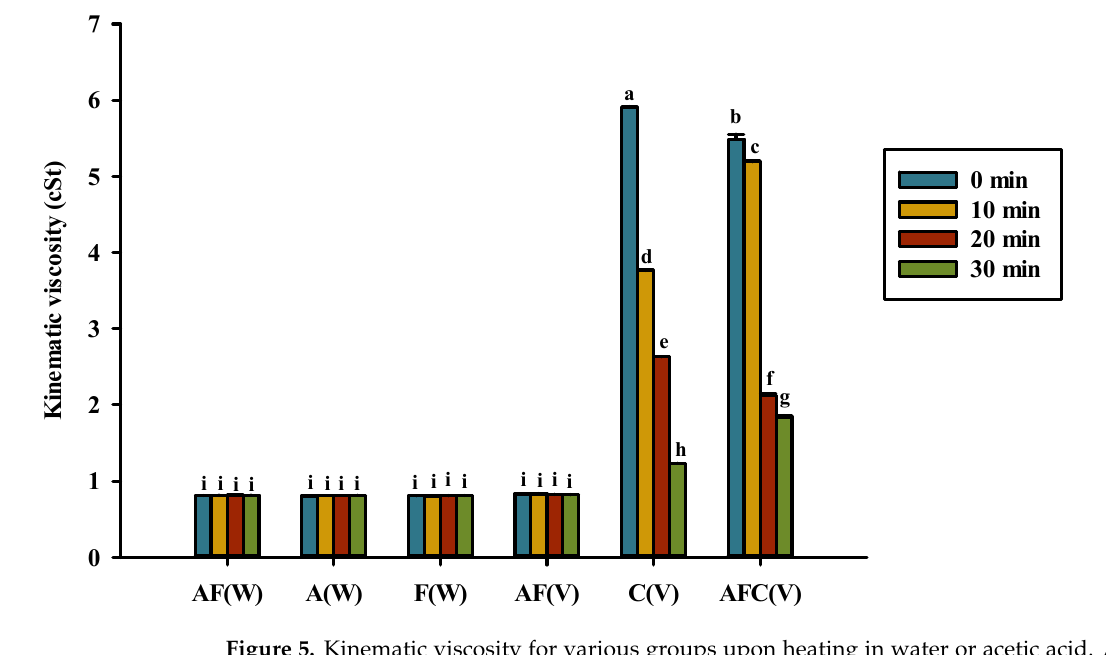
Figure 5. Kinematic viscosity for various groups upon heating in water or acetic acid. AF(W), asparagine and fructose in water; A(W), asparagine in water; F(W), fructose in water; AF(V), asparagine and fructose in acetic acid; C(V), chitosan in acetic acid; AFC(V), asparagine, fructose, and chitosan in acetic acid. Data represent the means of three replicates, and error bars indicate standard deviation. Bars followed by a common letter are not significantly different by the Dunn’s test at the 5% level of significance.